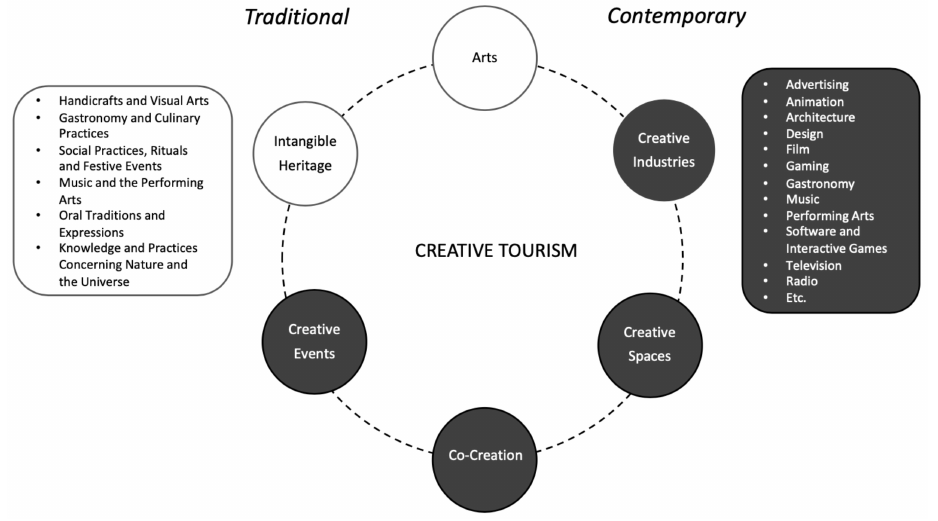
Figure 3. A typology of creative tourism approaches. Source: own